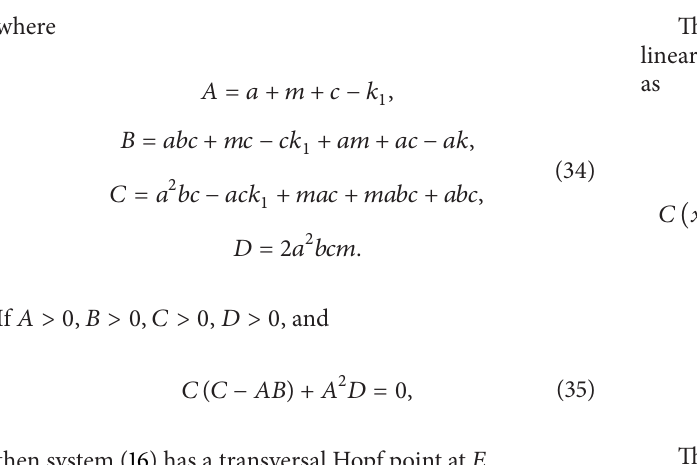
Figure 15: Experimental observations of the chaotic attractor in different